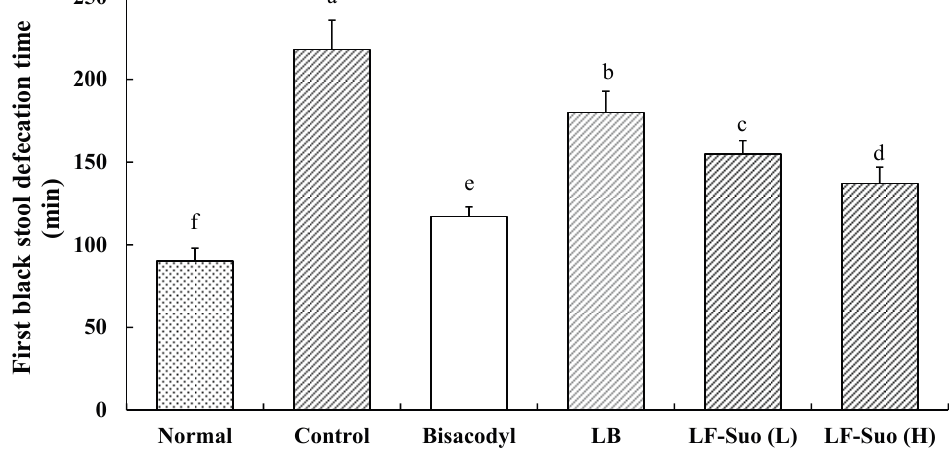
Figure 3. Small intestine of activated carbon-induced constipation model mice. n = 10 ICR mice in each group, bisacodyl: 100 mg/kg b.w.; LB: Lactobacillus bulgaricus (1.0 × 10 9 CFU/kg b.w.); LF-Suo (L): Lactobacillus fermentum Suo (0.1 × 10 9 CFU/kg b.w.);